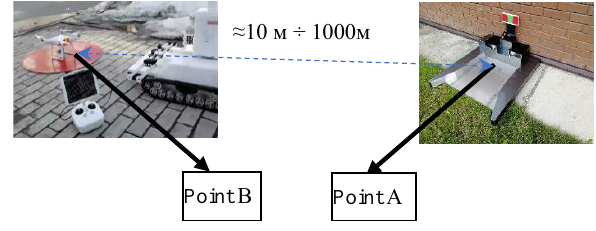
Figure 2. Battery changing and charging